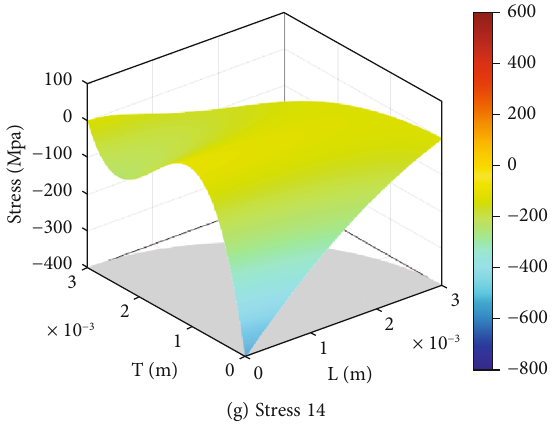
Figure 6: Stress distributions on the corner crack.